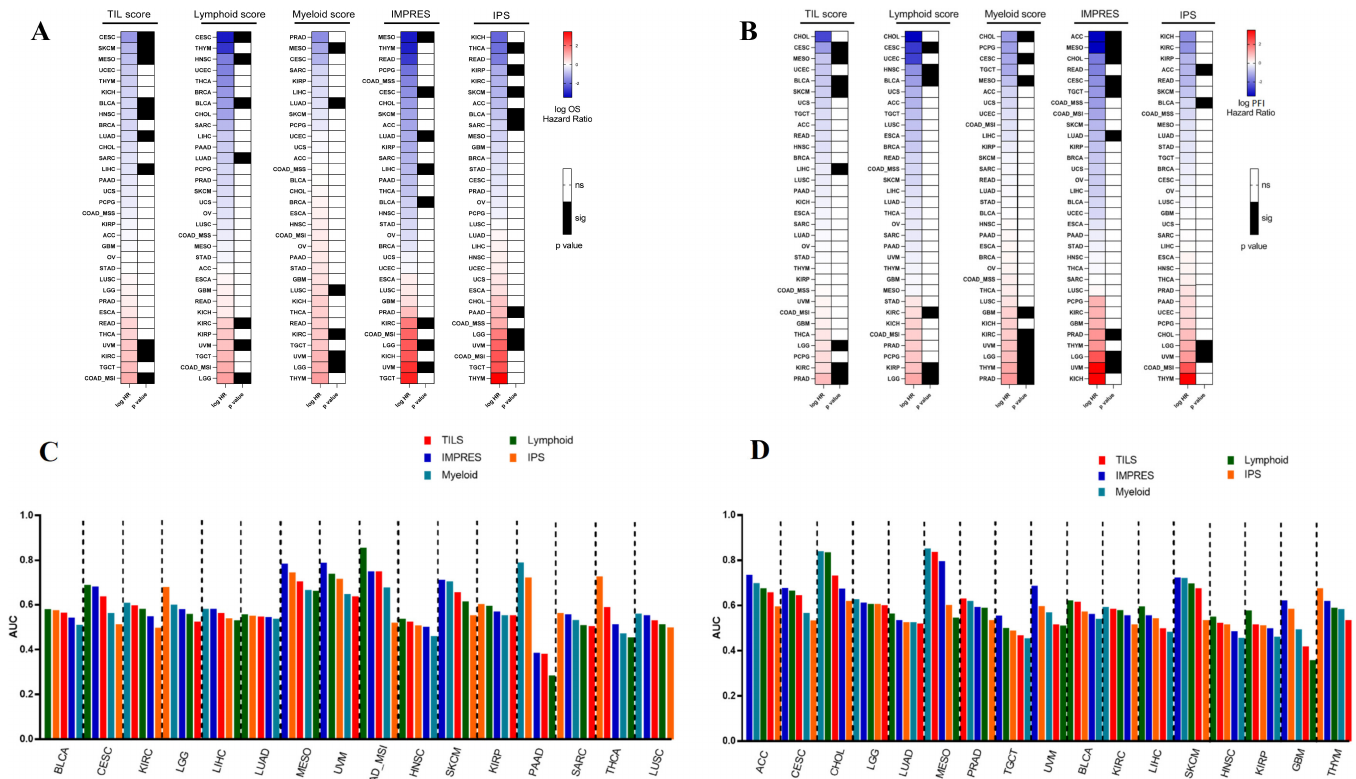
Figure 3. Evaluation of the prognostic role of the TIL and lymphoid scores in the Pan-Cancer TCGA cohort. ( A , B ): Log hazard ratios estimated by univariate Cox models for ( A ) overall survival (OS) and ( B ) progression-free interval (PFI) respectively associated with the TIL, lymphoid, myeloid, immunophenoscore (IPS) and IMmuno-PREdictive Score (IMPRES) scores, for each TCGA cancer type. Blue cells represent good prognosis and red cells represent poor prognosis. Black cells represent a p value for a log rank test less than 0.05. ( C , D ): For each significant TCGA tumor type from panel A and B respectively, bar plots are showing the area under the curve (AUC) estimated for overall survival ( C ) or progression-free interval ( D ) univariate survival models involving the five scores. For each tumor, the five scores are ordered decreasingly; the first score is the one that best predicts the